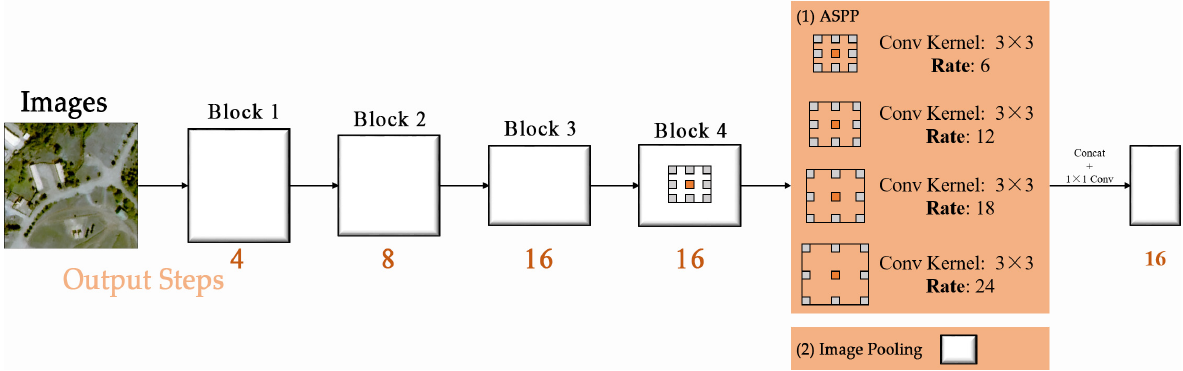
Figure 3. Conceptual graph of atrous convolution. ( A ) The 1 ‐ dilated conv of 3 × 3; ( B ) the 2 ‐ dilated conv of 3 × 3; ( C ) the 4 ‐ dilated conv of 3 × 3.